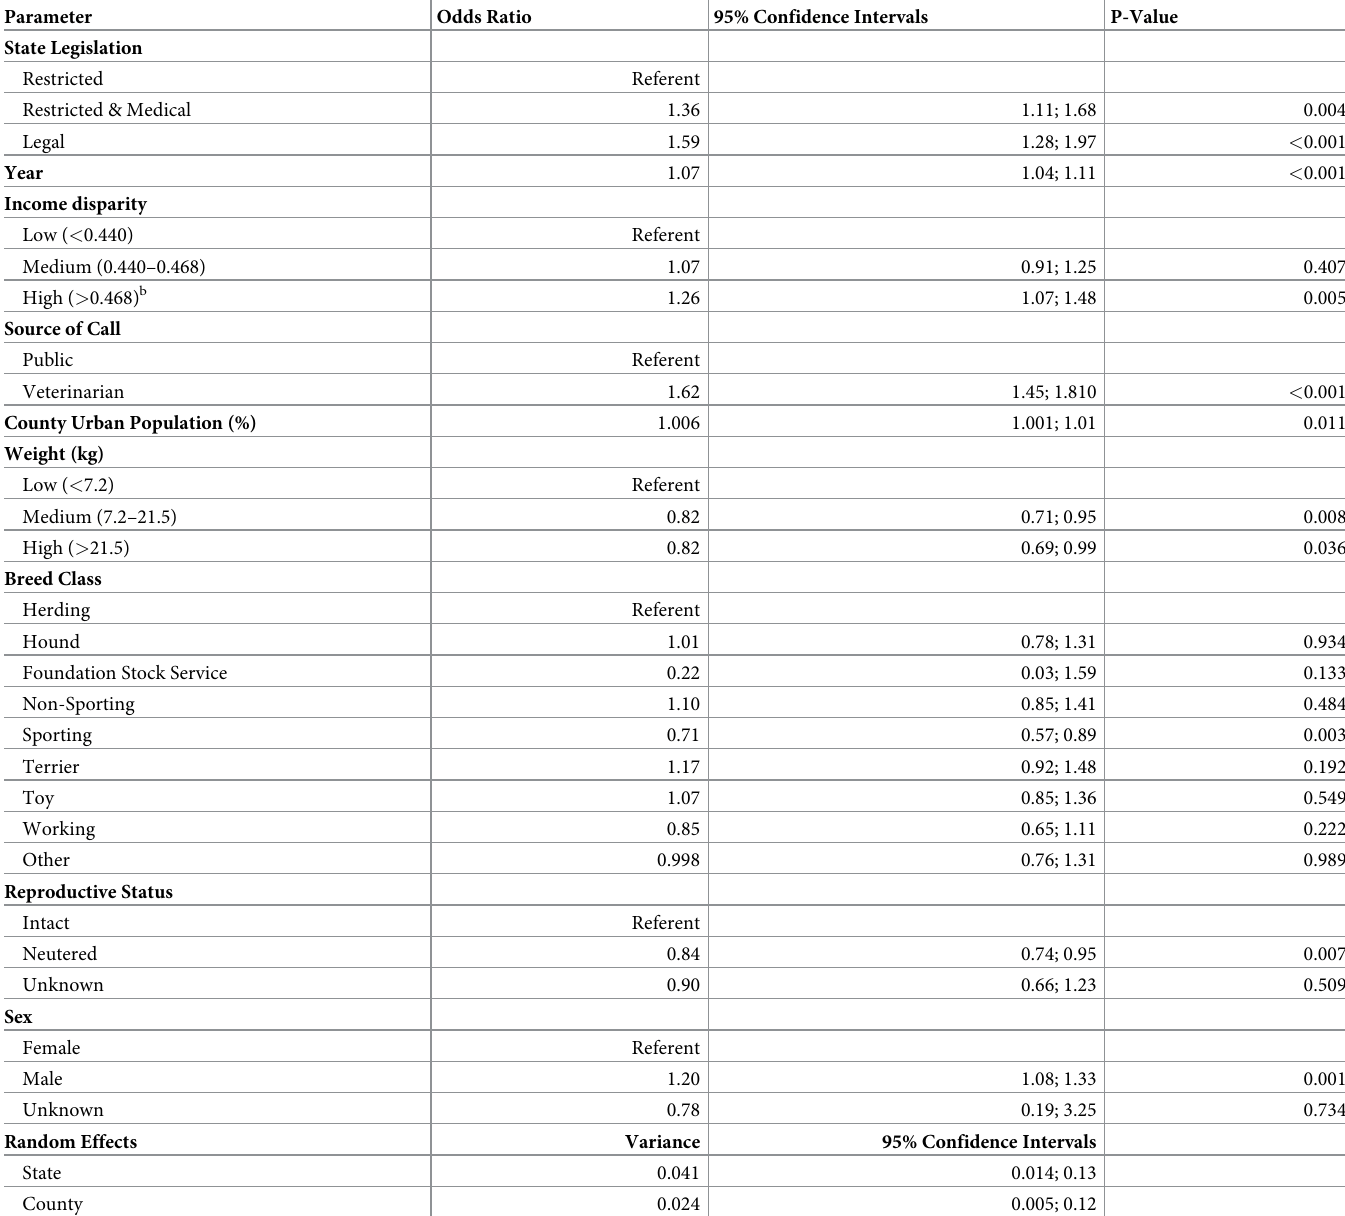
Table 7. Results of multivariable mixed logistic regression model † examining the associations between each dog-level and community-level variable on the odds of a poisoning call to the APCC a being related to cannabis (2009–2014).